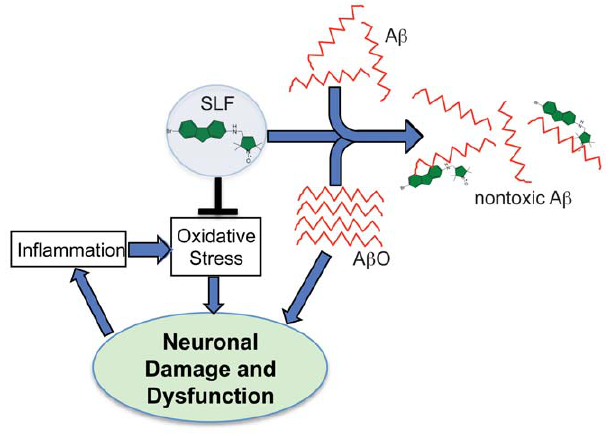
Figure 13. Model of action of SLFs on A b O assemblies. The illustration highlights the bifunctional properties of the SLF, including its ability to block the formation of nm particles and disrupt small oligomers, as well as its antioxidant activity. The ability of SLF to disrupt fibrils or more mature fibrillar oligomers [32] is undetermined.